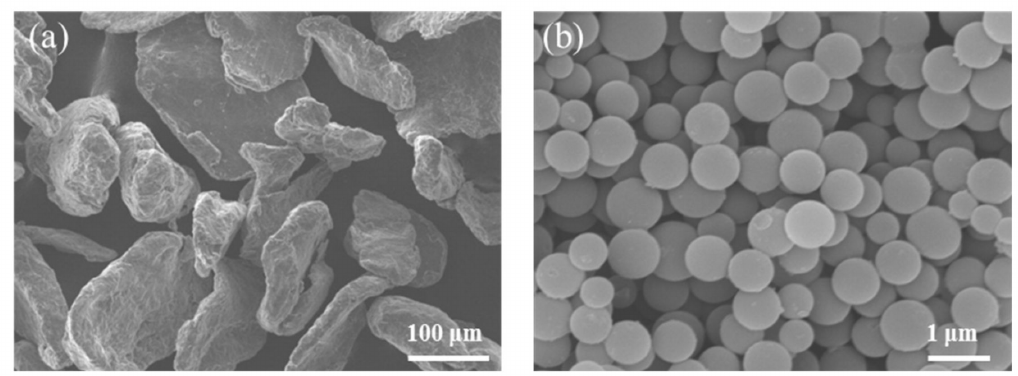
Figure 1. Field emission scanning electron microscopy (FESEM) image of ( a ) the Mg powders and ( b ) the microporous carbon nanospheres